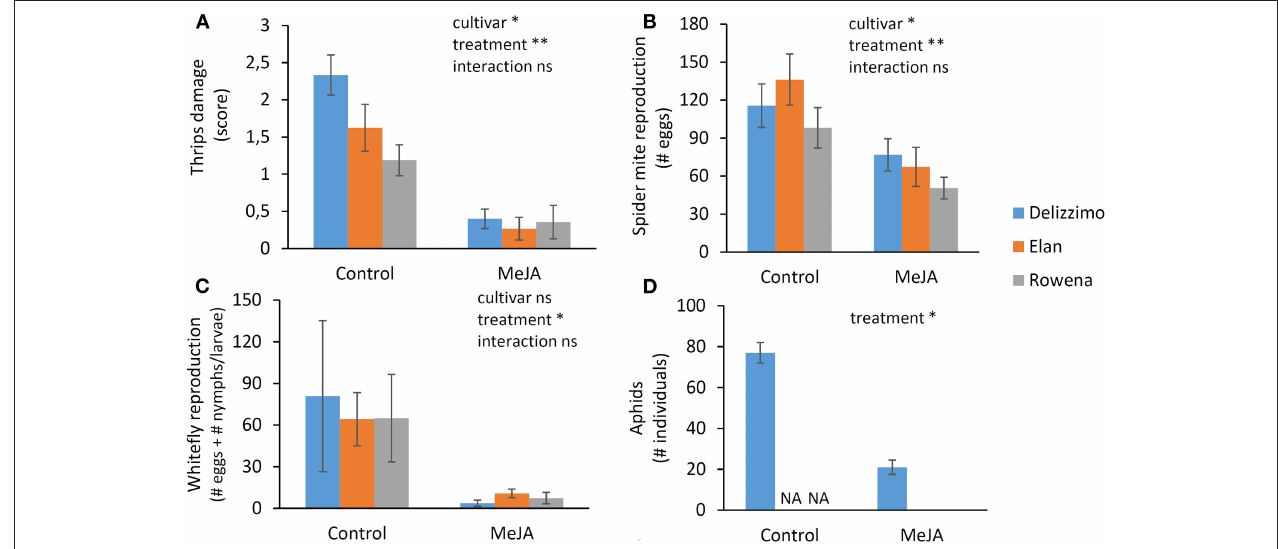
FIGURE 2 | Effect of MeJA treatment on plant resilience against the four major pests during strawberry plant nursery as measured in whole-plant bioassays. (A) Thrips ( Frankliniella occidentalis ) leaf damage, scale score: 0 ( no damage ) to 5 ( severe damage ), (B) spider mite ( Tetranychus urticae ) reproduction (number of eggs per plant), (C) greenhouse whitefly ( Trialeurodes vaporariorum ) reproduction (number of eggs and number of larvae/nymphs per plant), (D) Buckthorn aphids ( Aphis nasturtii ) reproduction (number of individuals (all stages) per plant). Data present mean ± SEM ( n = 8). Significant differences are indicated as * p ≤ 0.01, ** p ≤ 0.001, based on GLM using a Wald chi-squared